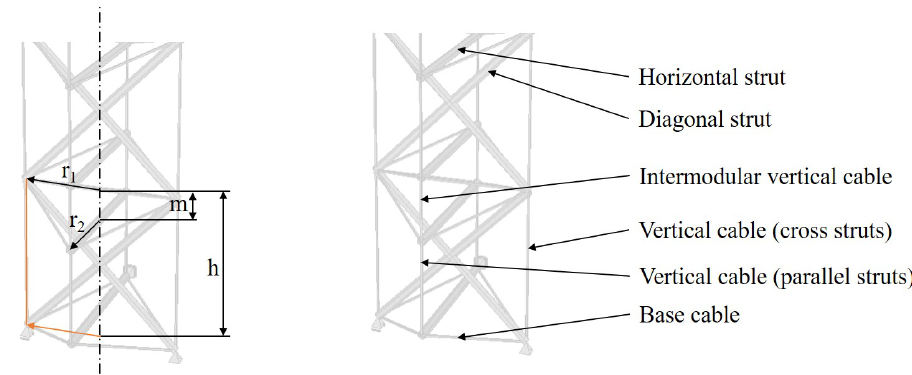
Figure 6. Octahedron